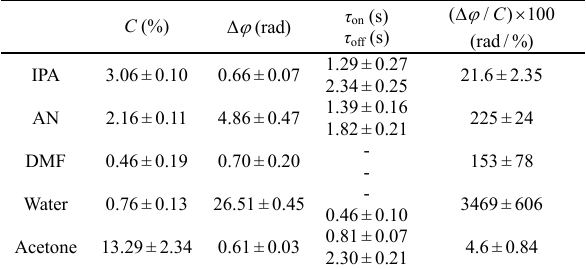
Table 1 Experimental parameters and results of volatile solvent sensing using a waveguide with 1.2 μ m thick organic glass PMMA + DMABI-Ph6 cladding. Here C is the organic solvent gas volume concentration in N 2 , Δ  is the resulting phase change,  on and  off are the ON and OFF switching times, and ( / ) 100 C   is the calculated sensitivity of MZI waveguide device to vapor of different organic